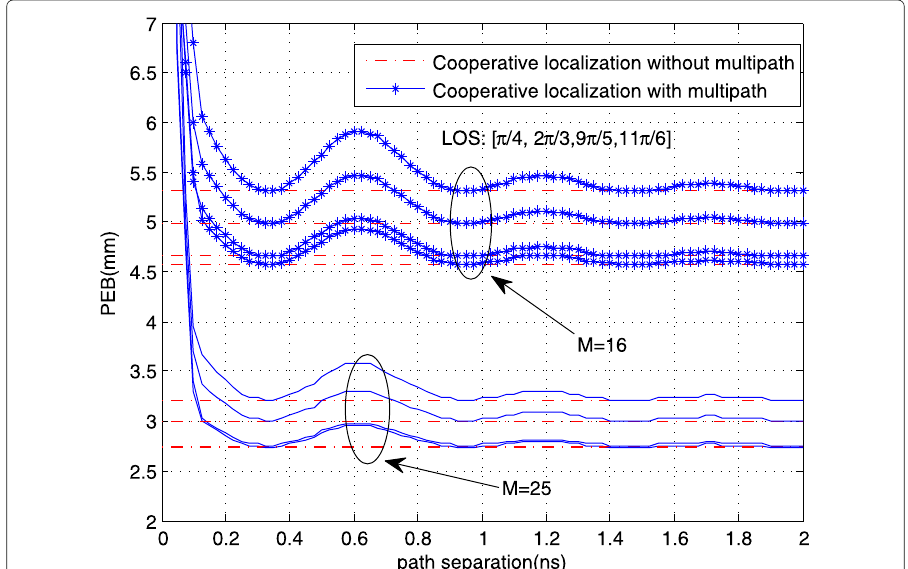
Fig. 11 PEB of single anchor-based cooperative localization, as a function of path separation, where different antenna elements are